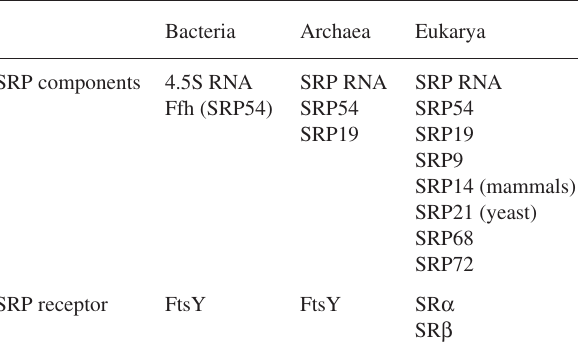
Table 1. Components of the signal recognition particle (SRP)-medi- ated pathway in the three domains of life.